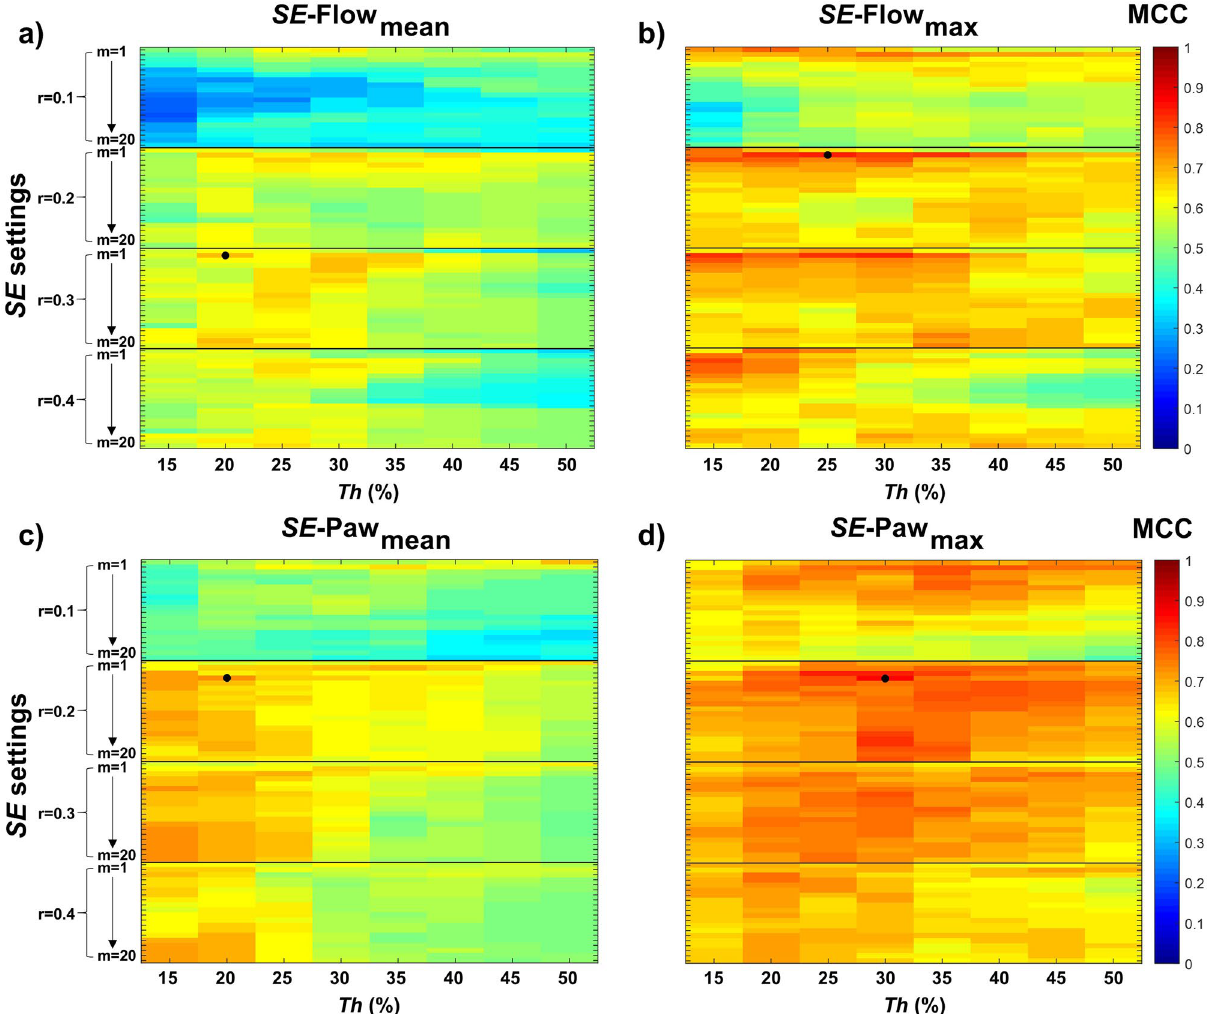
Figure 5. Repeated holdout cross-validation process for optimization of sample entropy ( SE ) settings and threshold ( Th ) for the detection of complex patient-ventilator interactions. We calculated the mean Matthews correlation coefficient (MCC) for each derived feature analyzed and each combination of m (1 to 20), r (0.1, 0.2, 0.3, and 0.4 times the SD of each sliding window), and Th (15%, 20%, 25%, 30%, 35%, 40%, 45%, and 50%) a total of 15 times using different randomly selected subsets. The upper panels show the results of the optimization process for SE -airway flow ( SE -Flow), and the lower panels show the results for SE -airway pressure ( SE -Paw). The color bar in each subplot shows the mean MCC scale, where values near 1 indicate more robust and consistent results. The MCC was positive in all cases. The black dot in each subplot indicates the combination that yielded the maximum mean